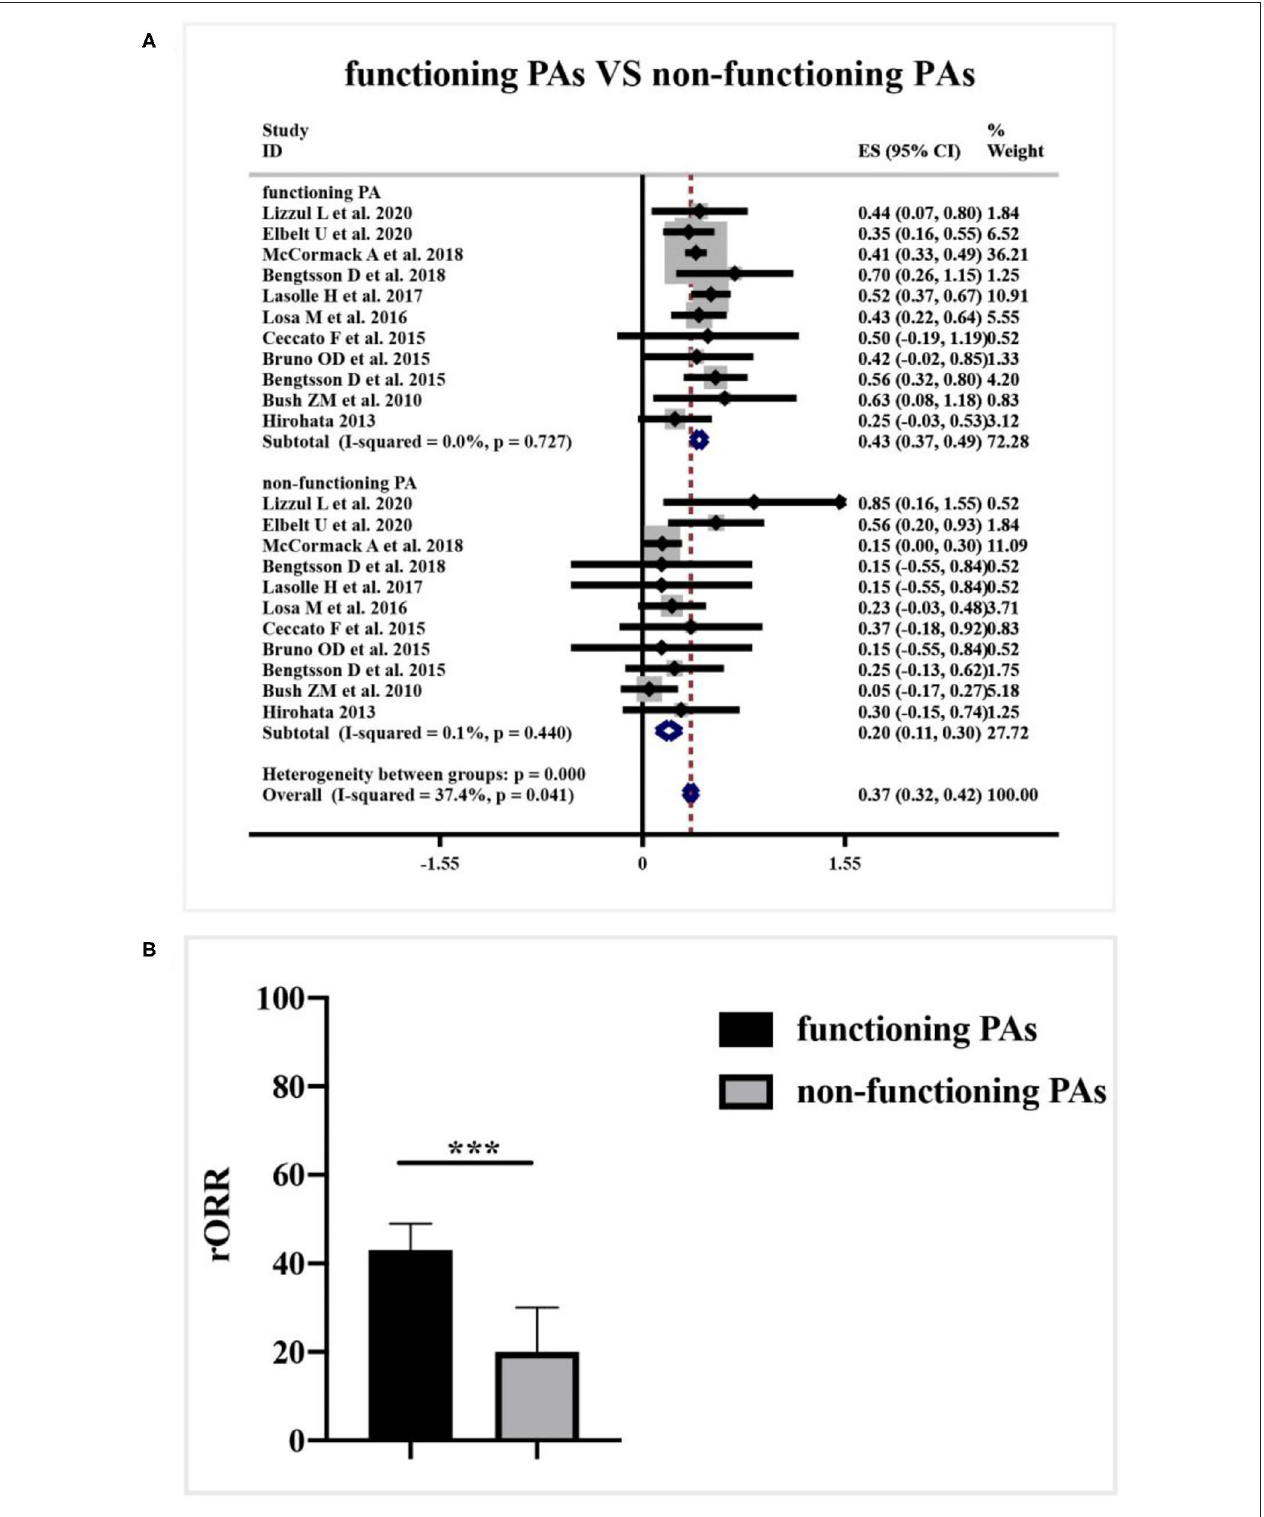
FIGURE 6 | Relationship between clinical functioning subtype and radiological response of TMZ in patients with APT and PC. (A) 43% radiological response rate to TMZ presented in the functioning subset, and non-functioning specimens only 20% radiological response. (B) The difference between groups was not dramatic as shown in the quantitative histogram. *** P <